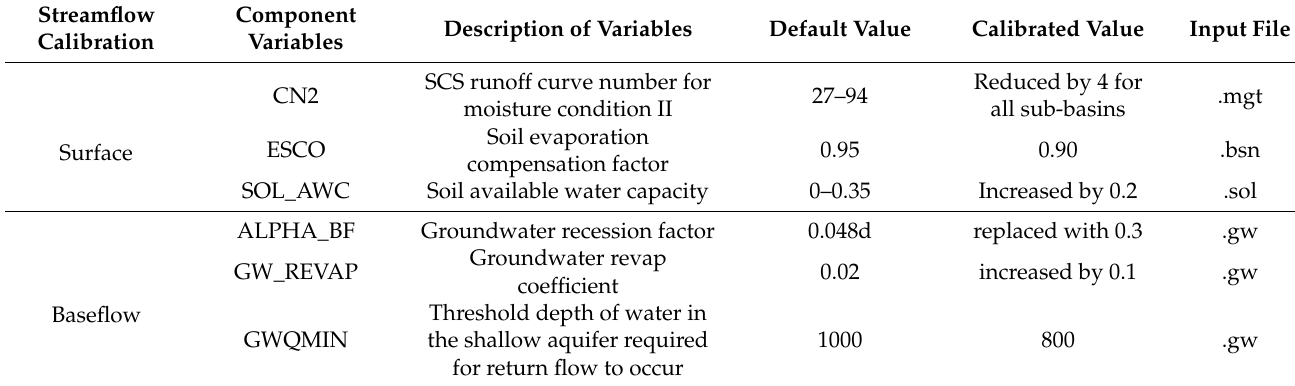
Table 4. Default and calibrated Soil and Water Assessment Tool (SWAT) variables values used in the study.